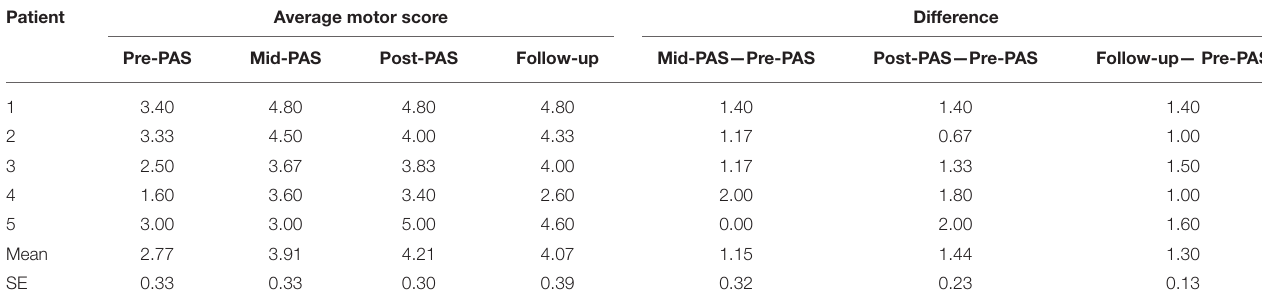
TABLE 4 | AIS motor scores.